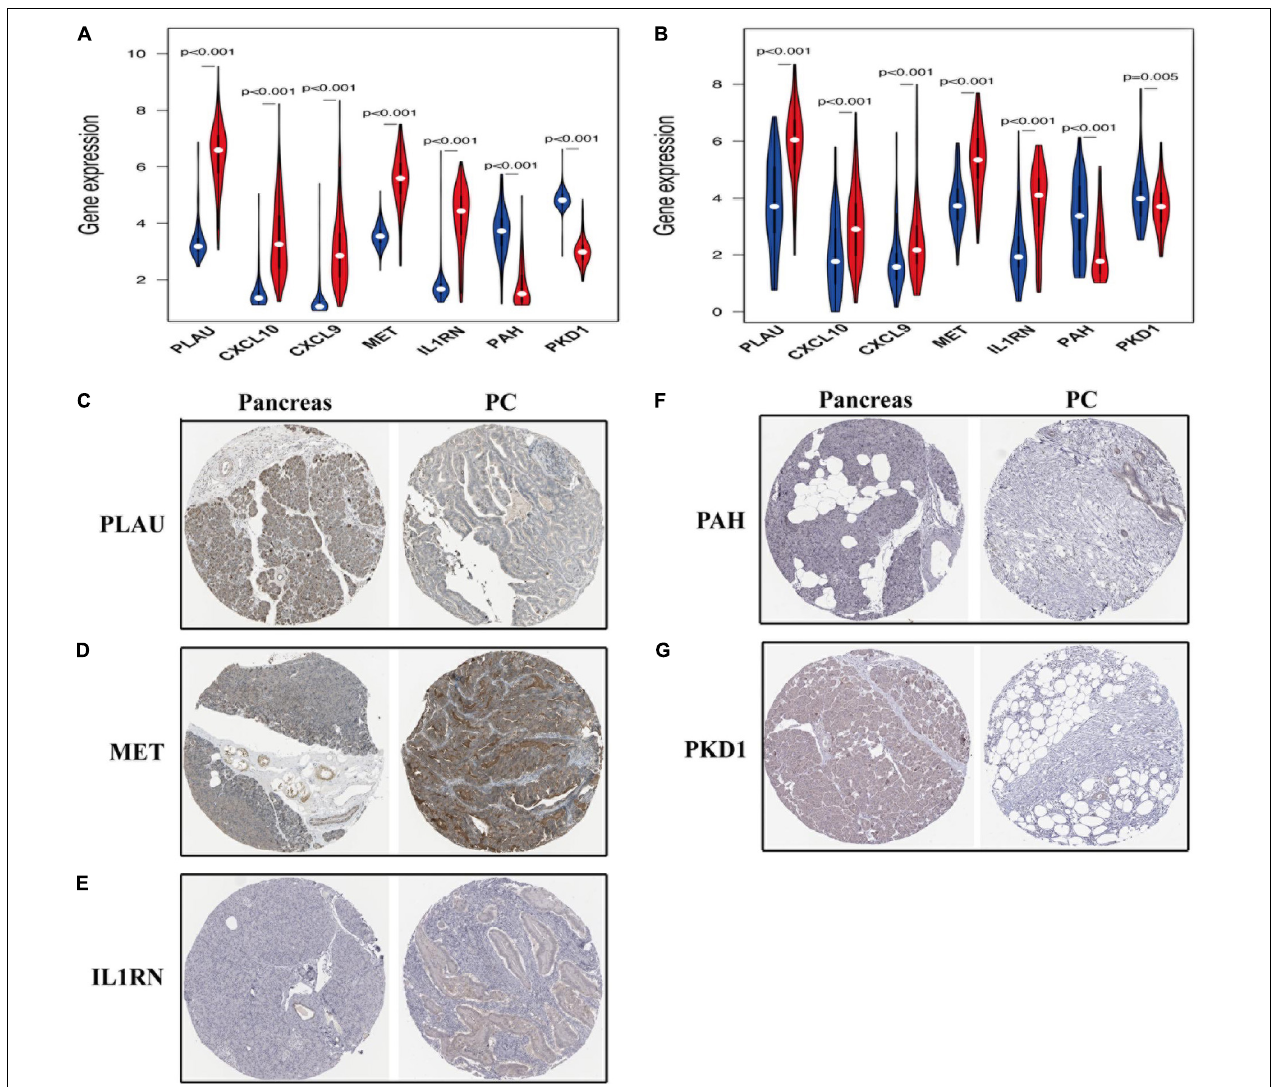
FIGURE 9 | The expression of prognosis-related OS genes in patients with PC. The violin plot reveals the transcription expression of OS genes in TCGA (A) and validation (B) cohorts. HPA database verifies the protein expression of PLAU (C) , MET (D) , IL1RN (E) , PAH (F) , and PKD1 (G) in